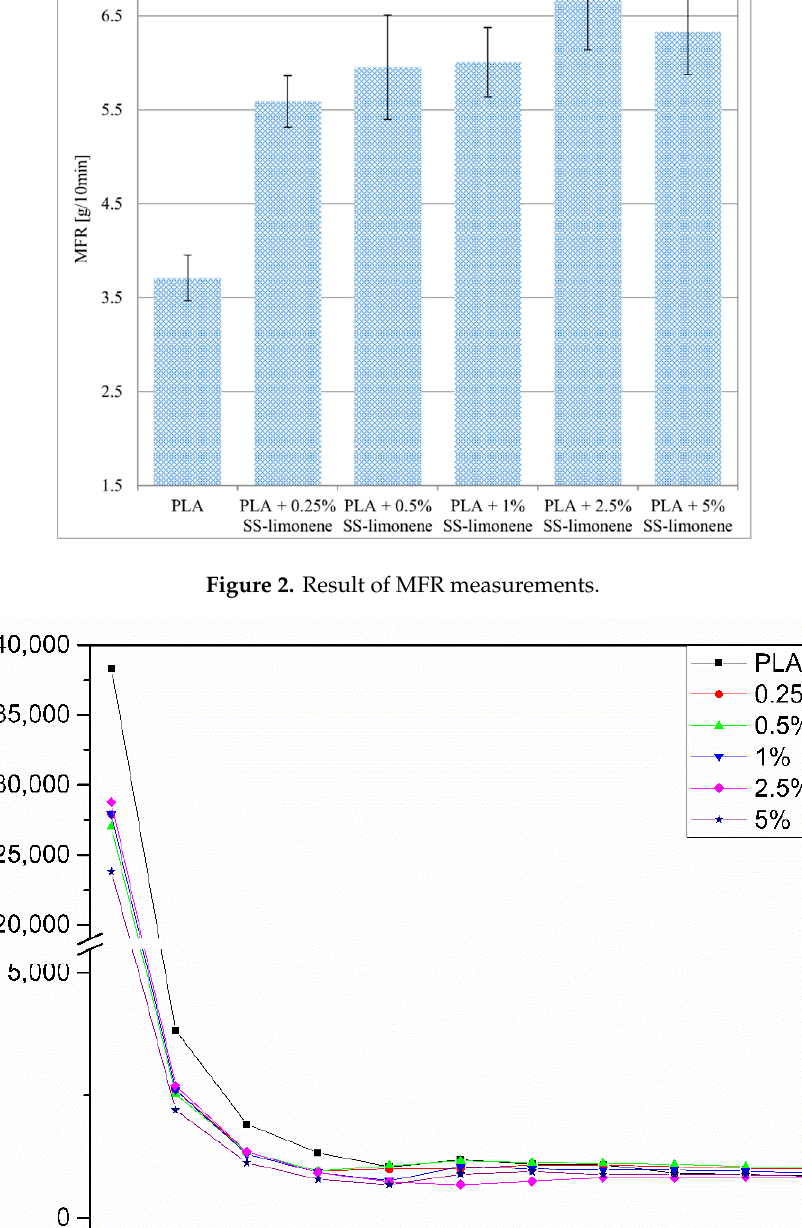
Figure 3. Viscosity measurement results.